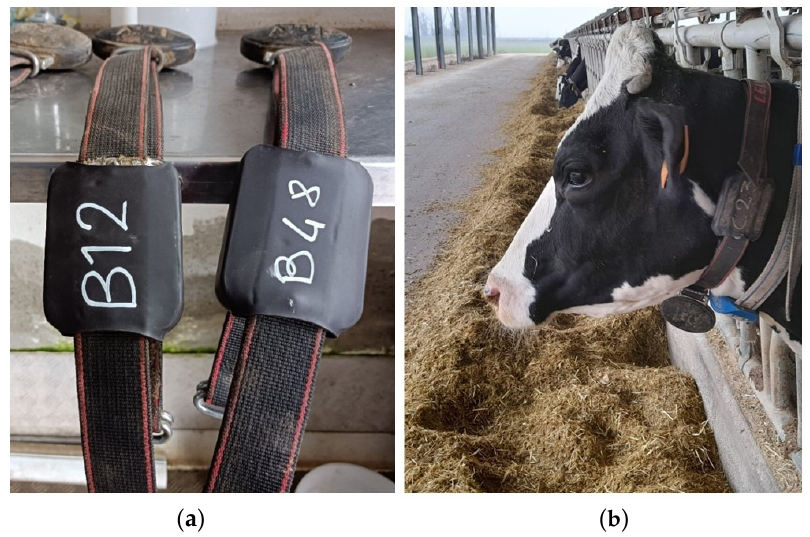
Figure 4. ( a , b ). Two sensor nodes mounted on two neck-collars (with the identification code written by pen) ( a ) and the position of the collar on the neck of a cow ( b ).